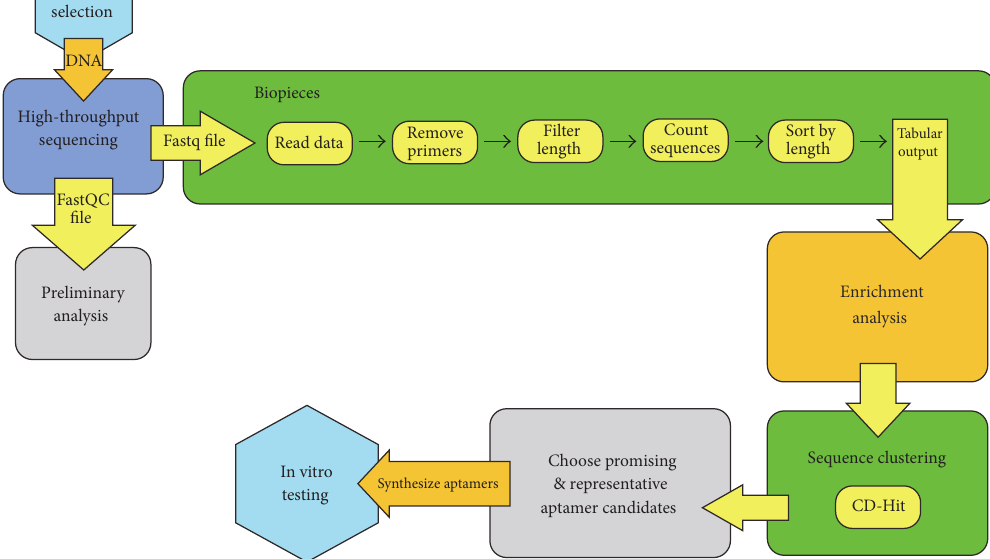
Figure 4: Flowchart showing the steps involved in analyzing high-throughput sequence data collected after a SELEX experiment. A series of sequence modification and counting steps is accomplished using Biopieces. Once tabulated based on abundance, the sequence information is analyzed using a locally written enrichment analysis script. CD-HIT is used to identify cluster sequences, and aptamers are chosen for characterization in vitro based on enrichment in response to the selective pressures of SELEX, their placement in a large sequence cluster, or both.